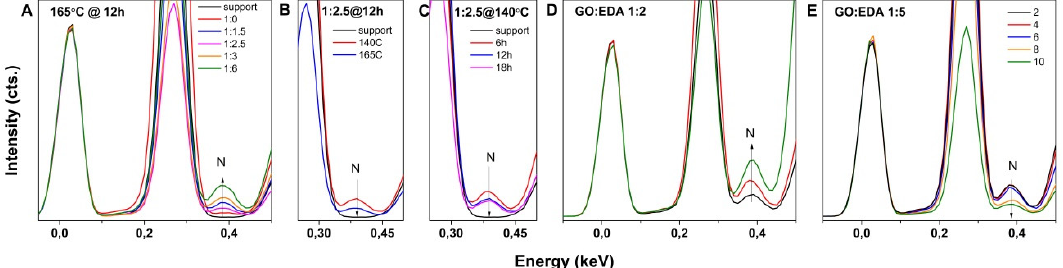
Figure 4. EDS spectra of EDA-functionalized GO aerogels from a 2 mg · mL − 1 GO dispersion by the HT approach ( A – C ) and the LT approach ( D , E ) as a function of the GO/EDA ratio, temperature, duration, and GO concentration (mg · mL − 1 ).